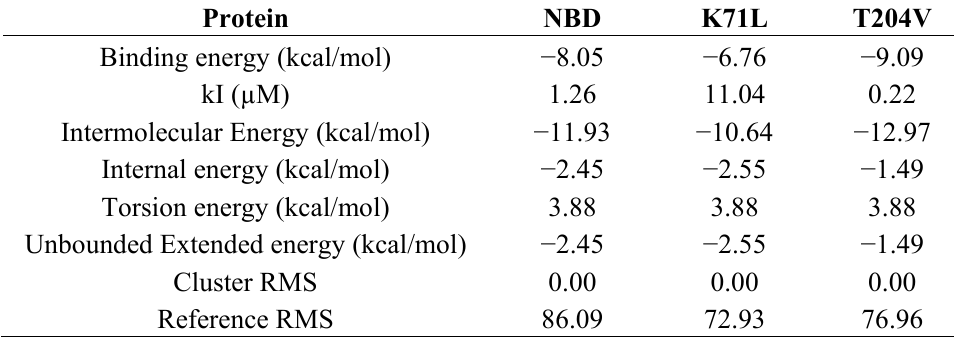
Table 5. Docking results of NBD protein, K71L and T204V mutants with the E1A32 kDa